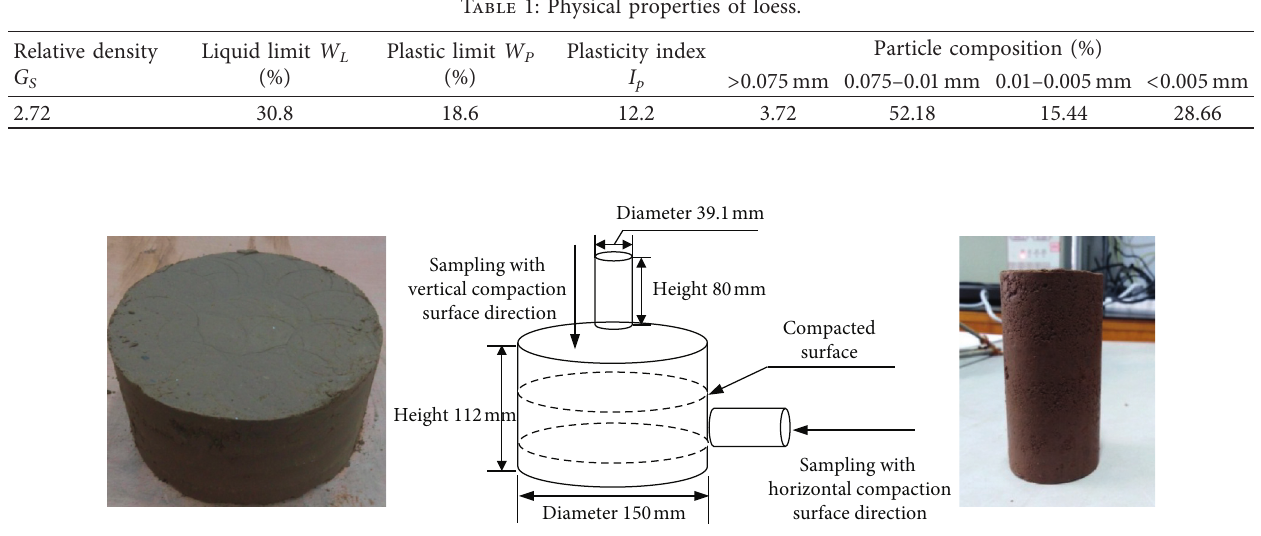
Figure 2: Sample of compacted loess and sampling direction.